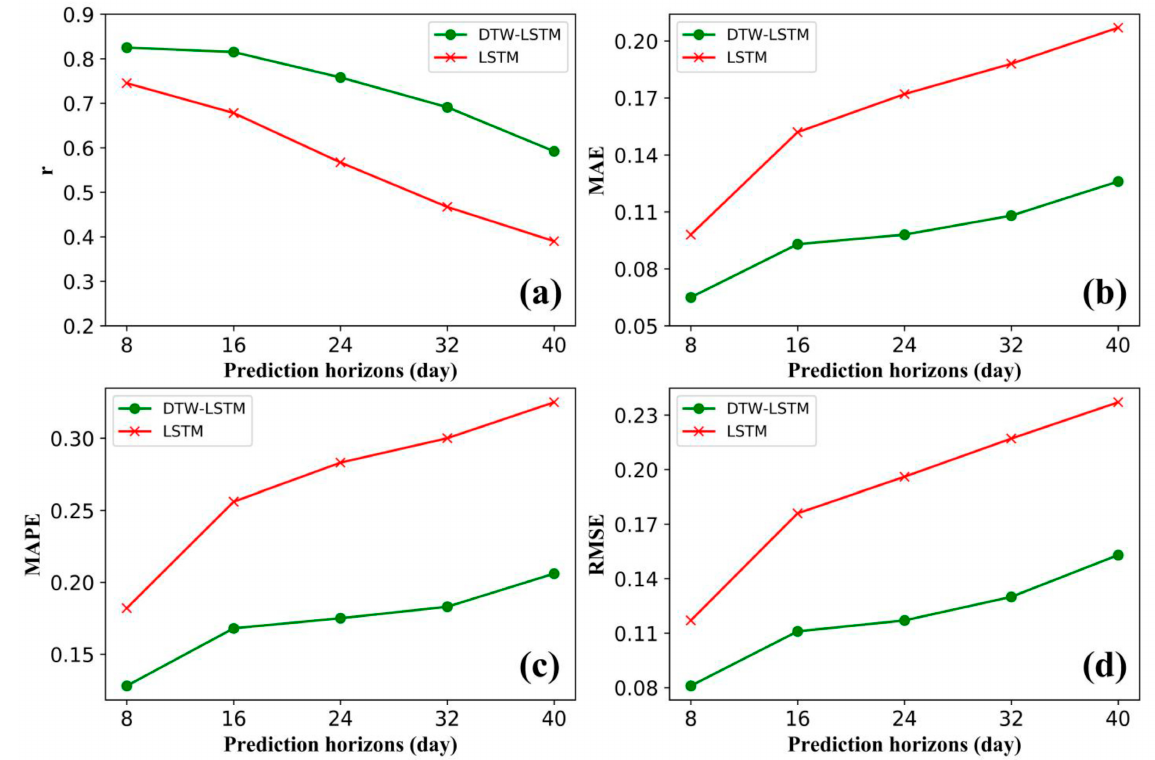
Figure 10. Comparison of the predictions between DTW–LSTM model and LSTM. ( a ) r, ( b ) MAE, ( c ) MAPE, ( d ) RMSE.